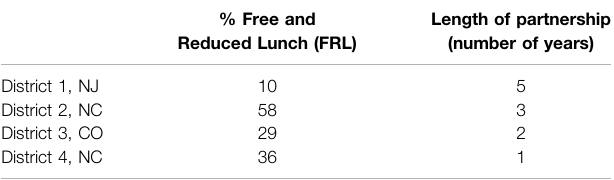
TABLE 3 | Descriptive statistics for MM6-8 ’ s district